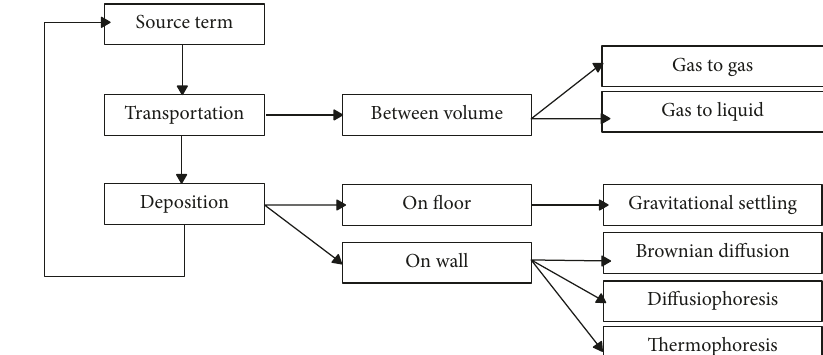
Figure 3: Calculation flow of ART Mod 2.